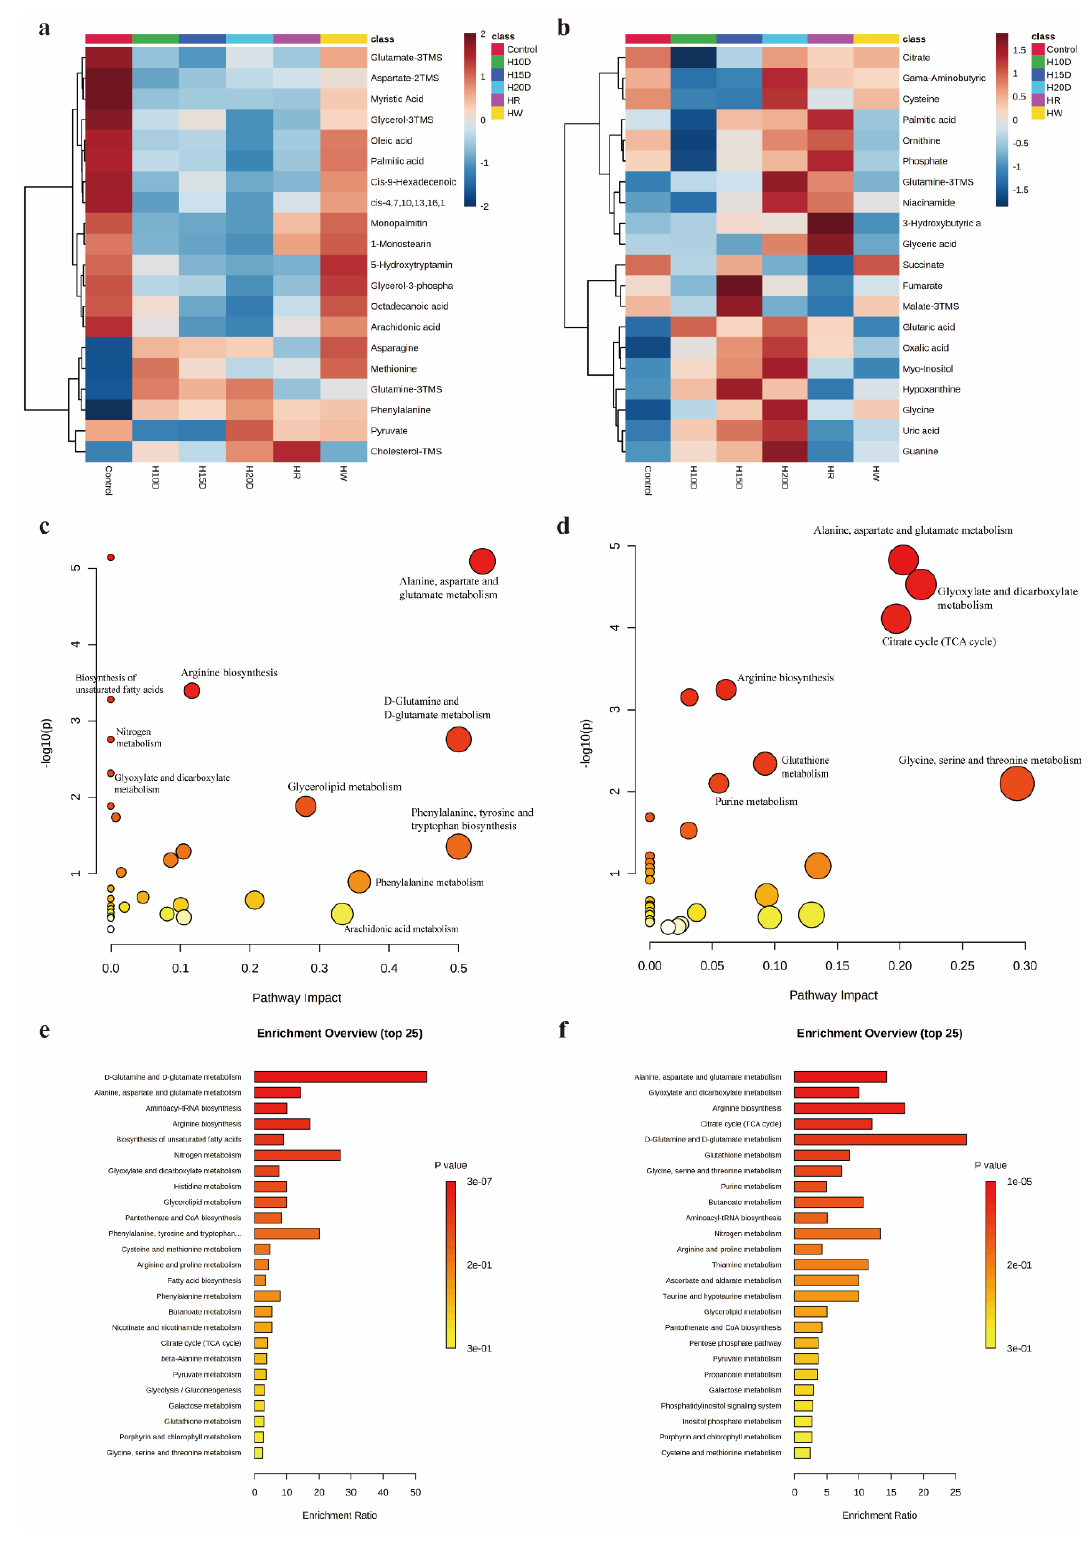
Figure 5. The heatmap of representative compound changes in serum and urine of methamphetamine mice and the metabolic pathways. ( a ) The heatmap of representative compound changes in serum. ( b ) The heatmap of representative compound changes in the urine. ( c ) The pathway impact of serum metabolites. ( d ) The pathway impact of urine metabolites. ( e ) Enrichment analysis of pathway-associated metabolite sets in serum. ( f ) Enrichment analysis of pathway-associated metabolite sets in